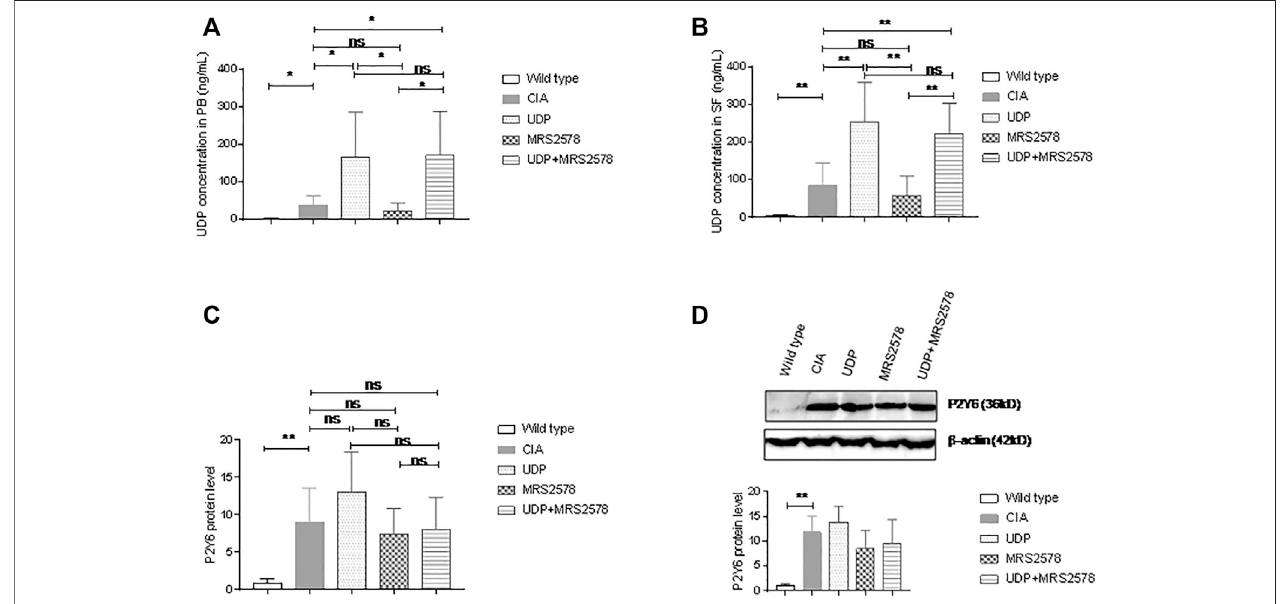
FIGURE 8 | UDP levels in synovial fl uids and P2Y6 expression in synovial tissues of CIA rats. (A) The UDP levels in rat peripheral blood were assessed using fl uorescence polarization analysis. (B) The UDP levels in rat synovial fl uids were assessed using fl uorescence polarization analysis. (C) P2Y6 expression in rat synovial tissues was assessed using real-time PCR. (D) P2Y6 expression in synovial tissues was assessed using Western blotting and statistical analysis. Each groups had nine rat samples. PB: peripheral blood, SF: synovial fl uids. * p < 0.05, ** p < 0.01 and *** p <